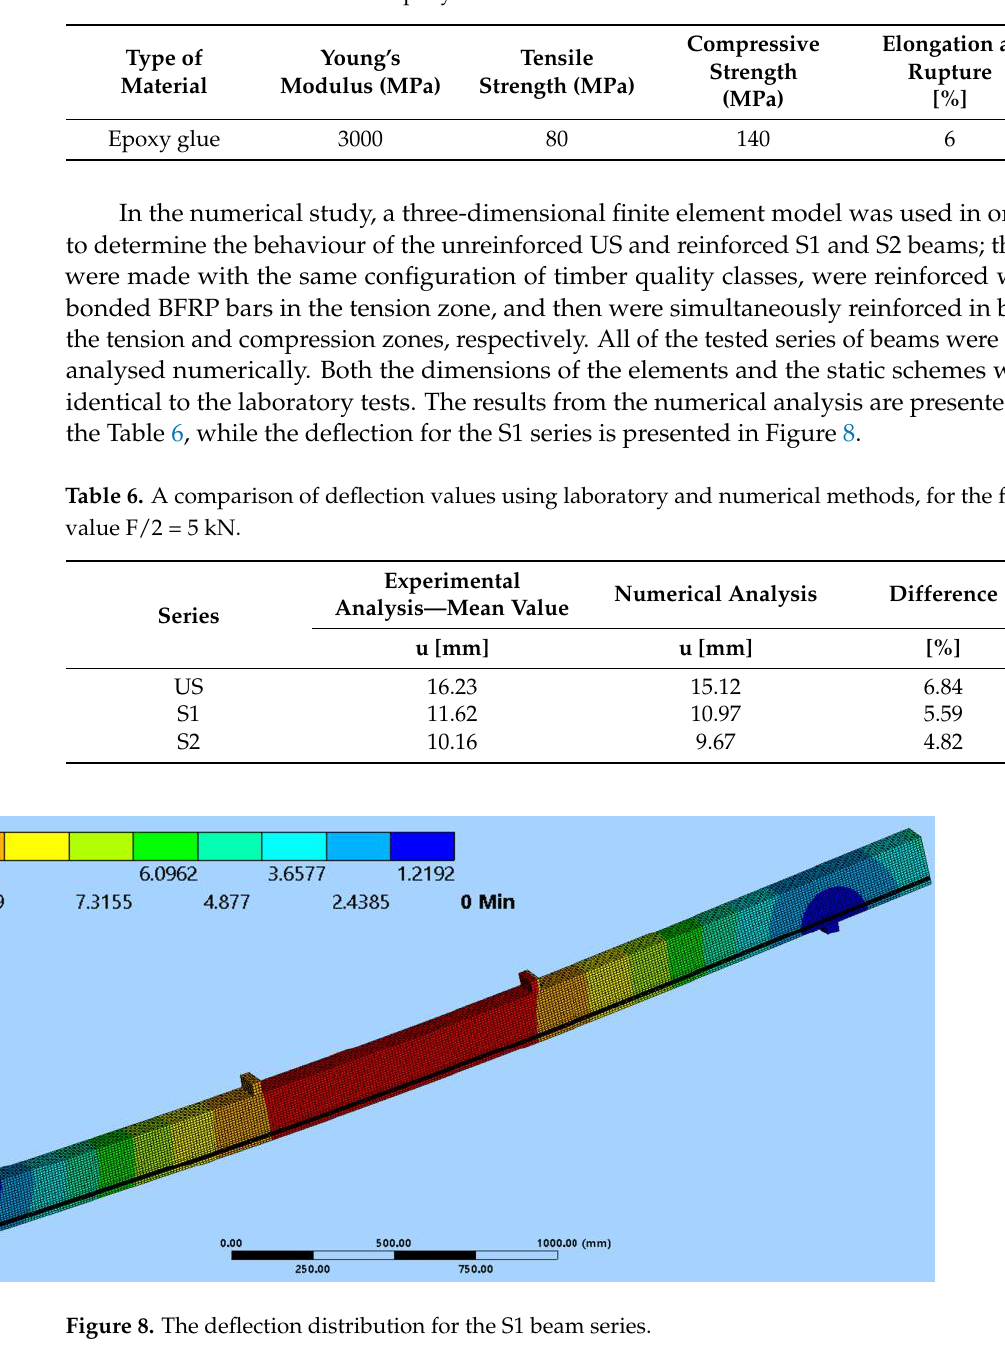
Table 6. A comparison of deflection values using laboratory and numerical methods, for the force value F/2 = 5